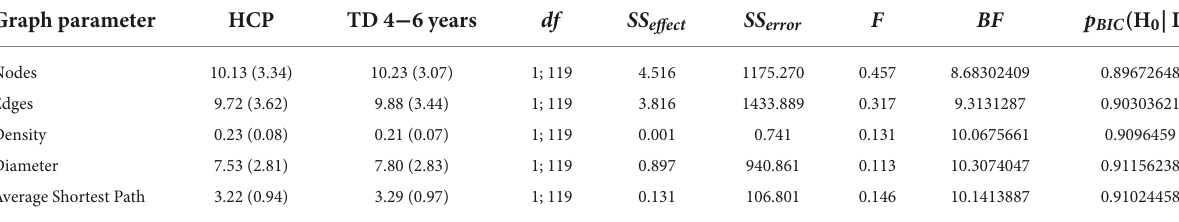
TABLE 4 Bayesian analysis investigating non-significant differences between the HCP and TD 4–6 year